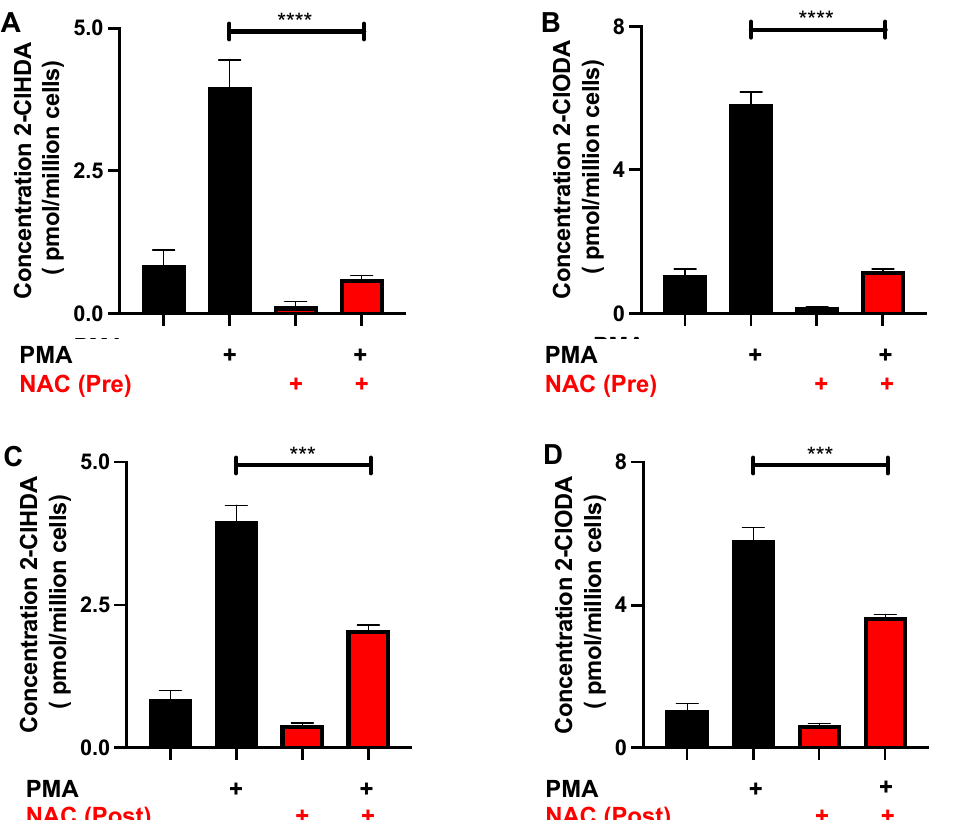
Figure 4. NAC sequesters 2-ClFALD produced by neutrophils. In total, 2 × 10 6 neutrophils were pretreated (Pre) with 12 mM NAC for 30 min as indicated before activation with 200 nM PMA as indicated ( A , B ). In separate experiments, 12 mM NAC was added to neutrophils as indicated 25 min after PMA activation (Post) ( C , D ). 2-ClHDA ( A , C ) and 2-ClODA ( B , D ) molecular species of 2-ClFALD were measured as described in “Materials and Methods”. n = 3 for each treatment from independent experiments. *** p < 0.001 and **** p < 0.0001 for comparison of the amount of 2-ClFALD in PMA-activated neutrophils treated with NAC in comparison to the treatment condition without NAC determined by ANOVA with Tukey’s post-hoc